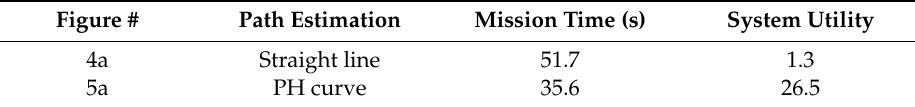
Table 6. Performance of different path estimation methods. Figure # Path Estimation Mission Time